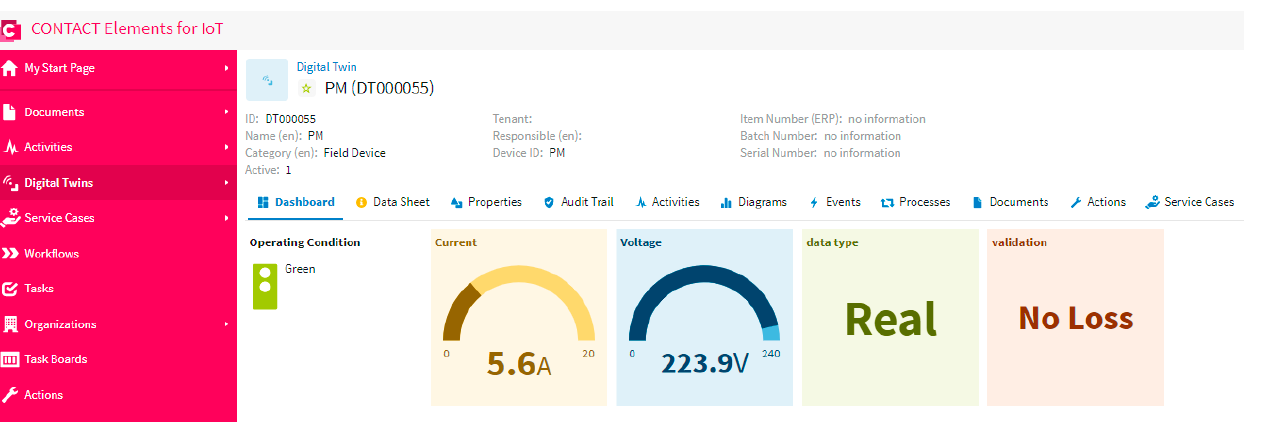
Figure 10. The dashboard of the IoT platform results in the case of scenario